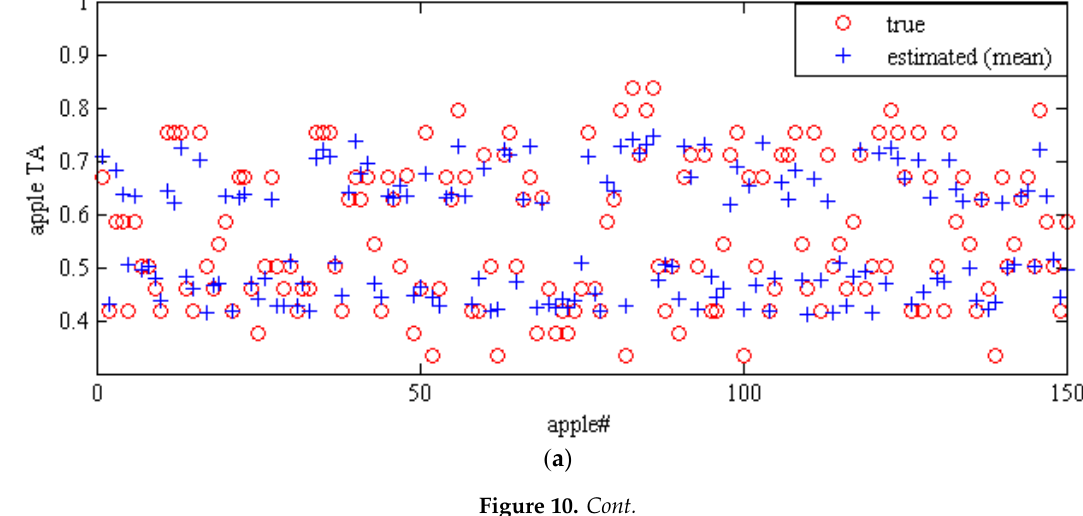
( b ) Figure 10. Graphic study of the performance of Methods. ( a ) ANN-PSO Algorithm and ( b ) PLSR for predicting the titratable acidity of Gala apples using spectral data related to key wavelengths. Table 13. Comparison of mean and standard deviation, different criteria evaluating the performance of the ANN-PSO algorithm and PLSR for estimating TA in 300 iterations using spectral data of key wavelengths. Method